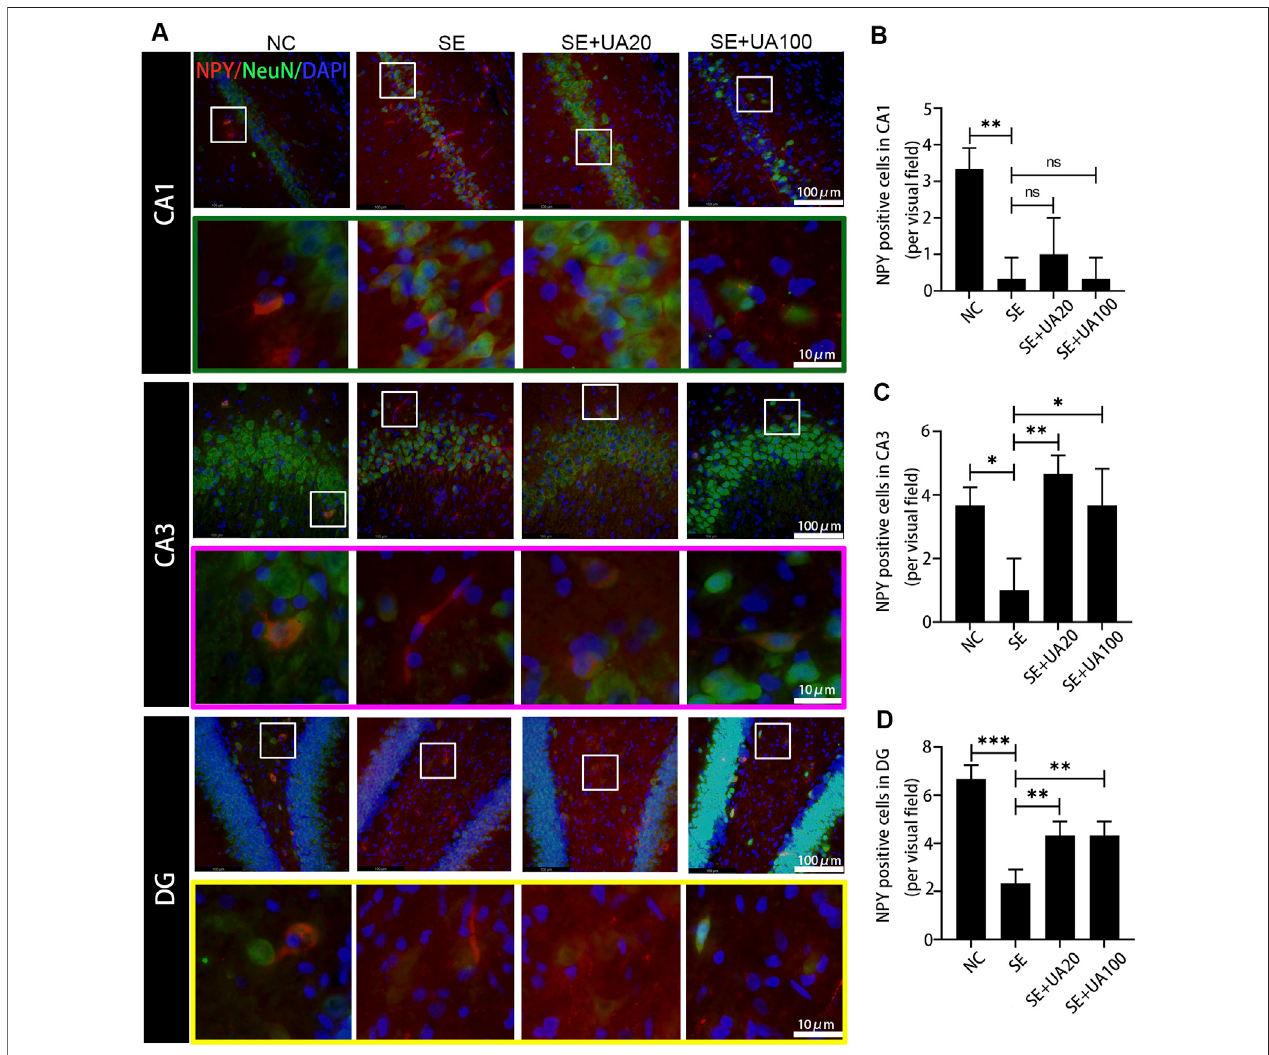
FIGURE10| UApromotedtheNPYexpression afterSEinduction. (A) Representativeimagesofimmuno fl uorescenttriple-stainingofNPY(red),NeuN(green),and DAPI (blue) in the CA1, CA3, and DG regions of rat hippocampus. (B – D) The number of NPY + cells in each region of the hippocampus after SE induction (three rats per group, all values were expressed as means ±SD, ppp p < 0.001, pp p < 0.01 vs . SE, one-way